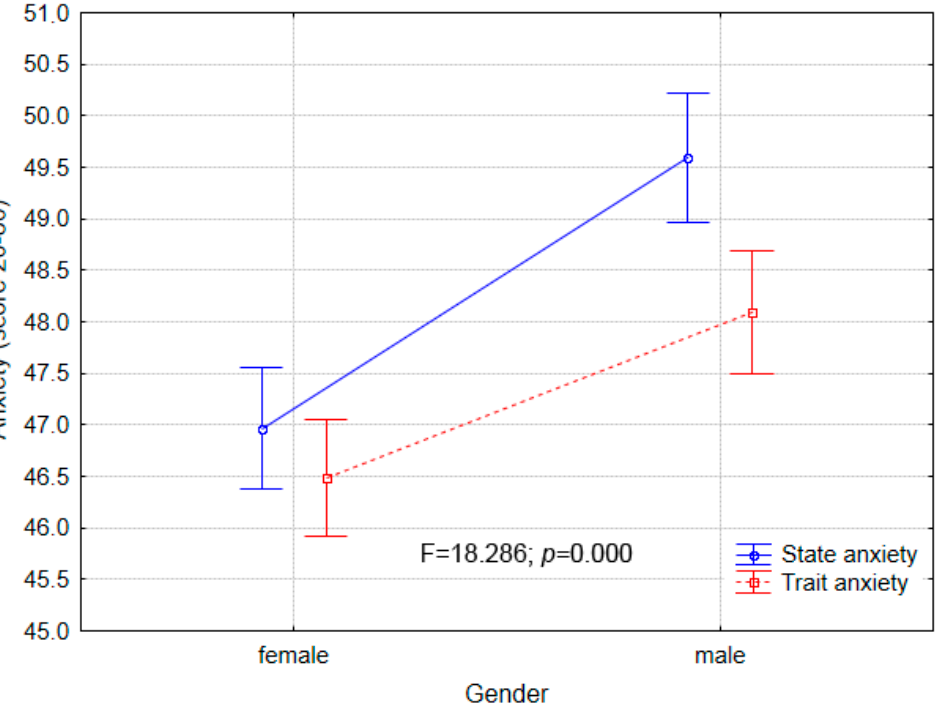
Figure 1. STAI items (state-anxiety and trait-anxiety) levels by gender of tested students. With group division by university, the lowest dispersion of scores for both state- and trait-anxiety was revealed by students of the National Academy of the National Guard